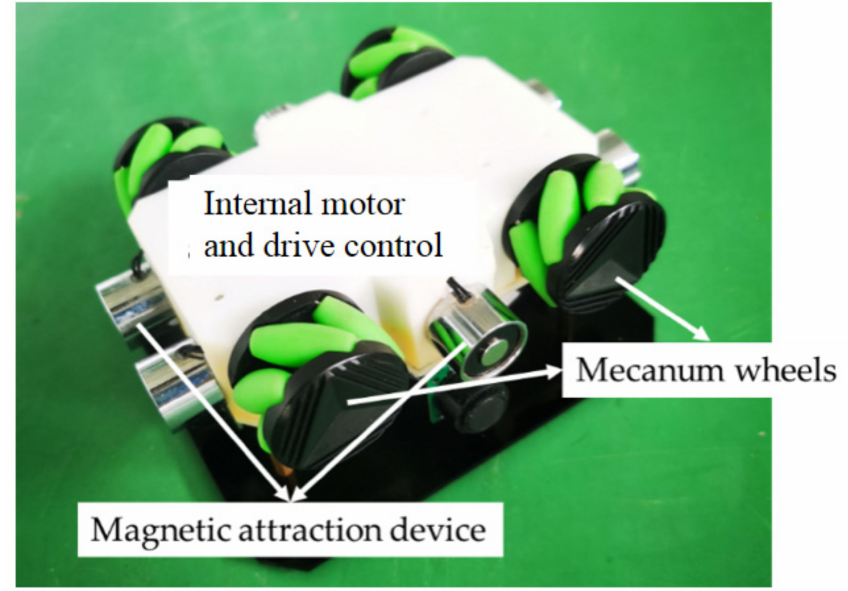
Figure 6. Model of a modular vehicle.